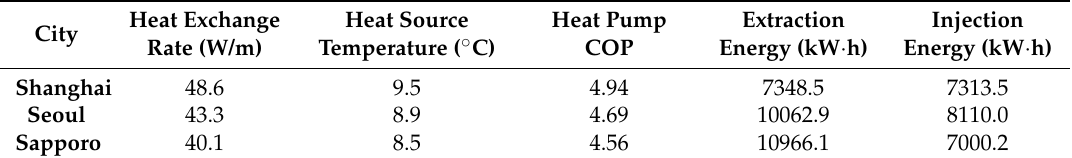
Table 6. Simulation results with different weather conditions.